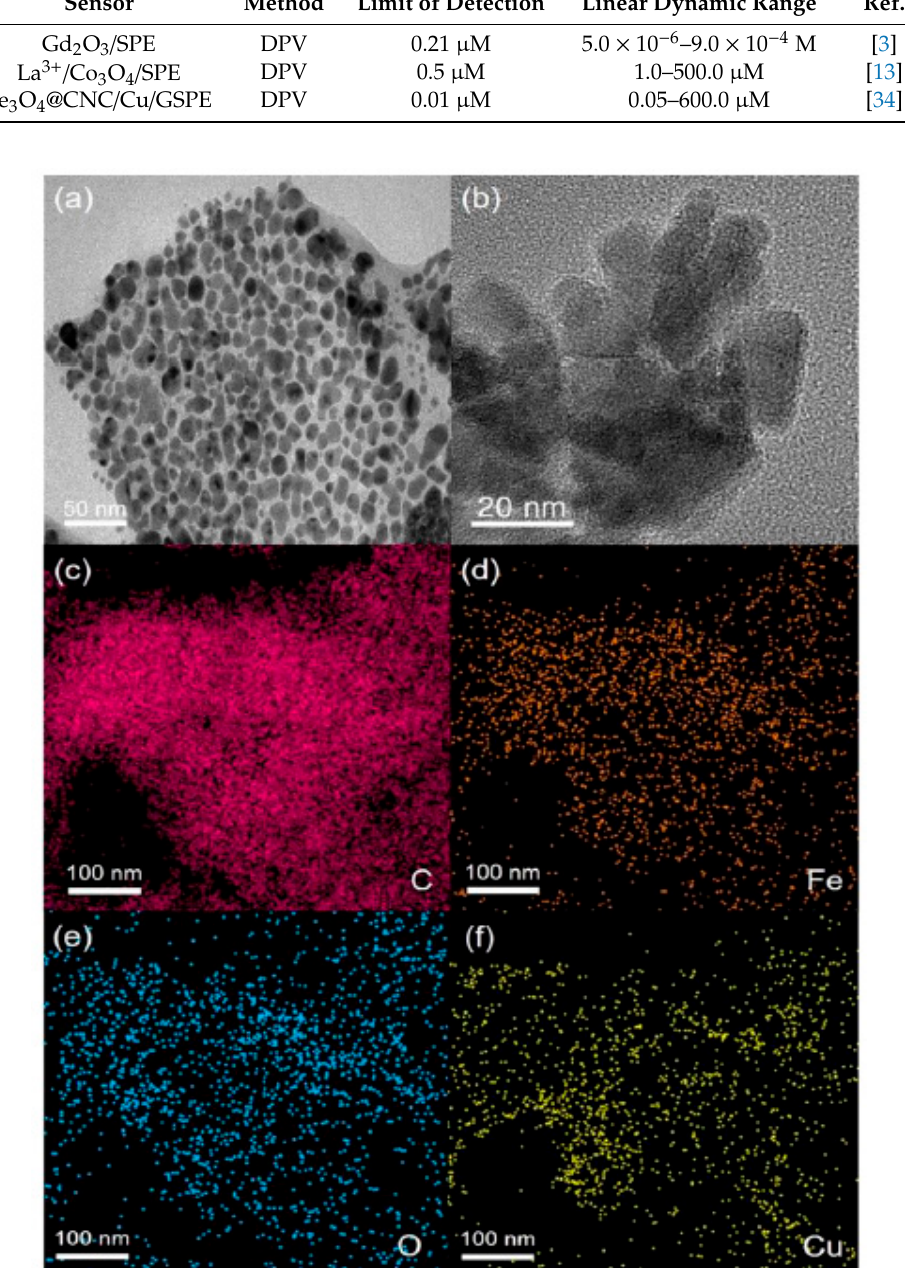
Figure 2. ( a , b ) Transmission electron microscopy (TEM), high resolution TEM (HRTEM) images; ( c , d , e , f ) energy dispersive X ‐ ray (EDX) map of (Fe 3 O 4 @CNC/Cu). Reproduced with permission [34]. Copyright ( c – f ) energy dispersive X-ray (EDX) map of (Fe